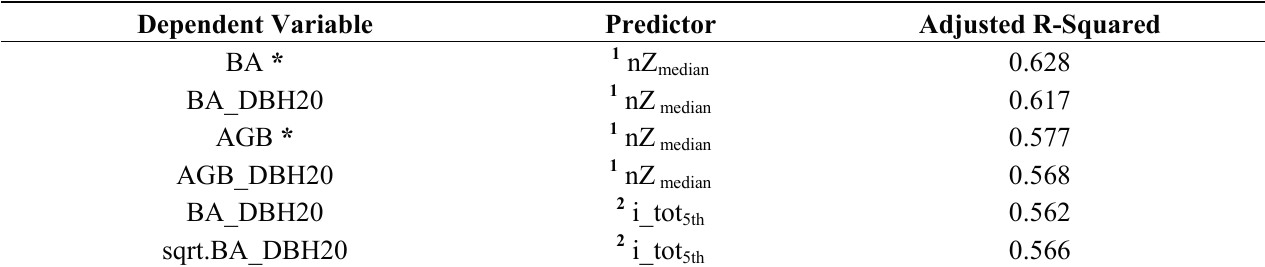
Table 3. Selected metrics with adjusted R-squared greater than